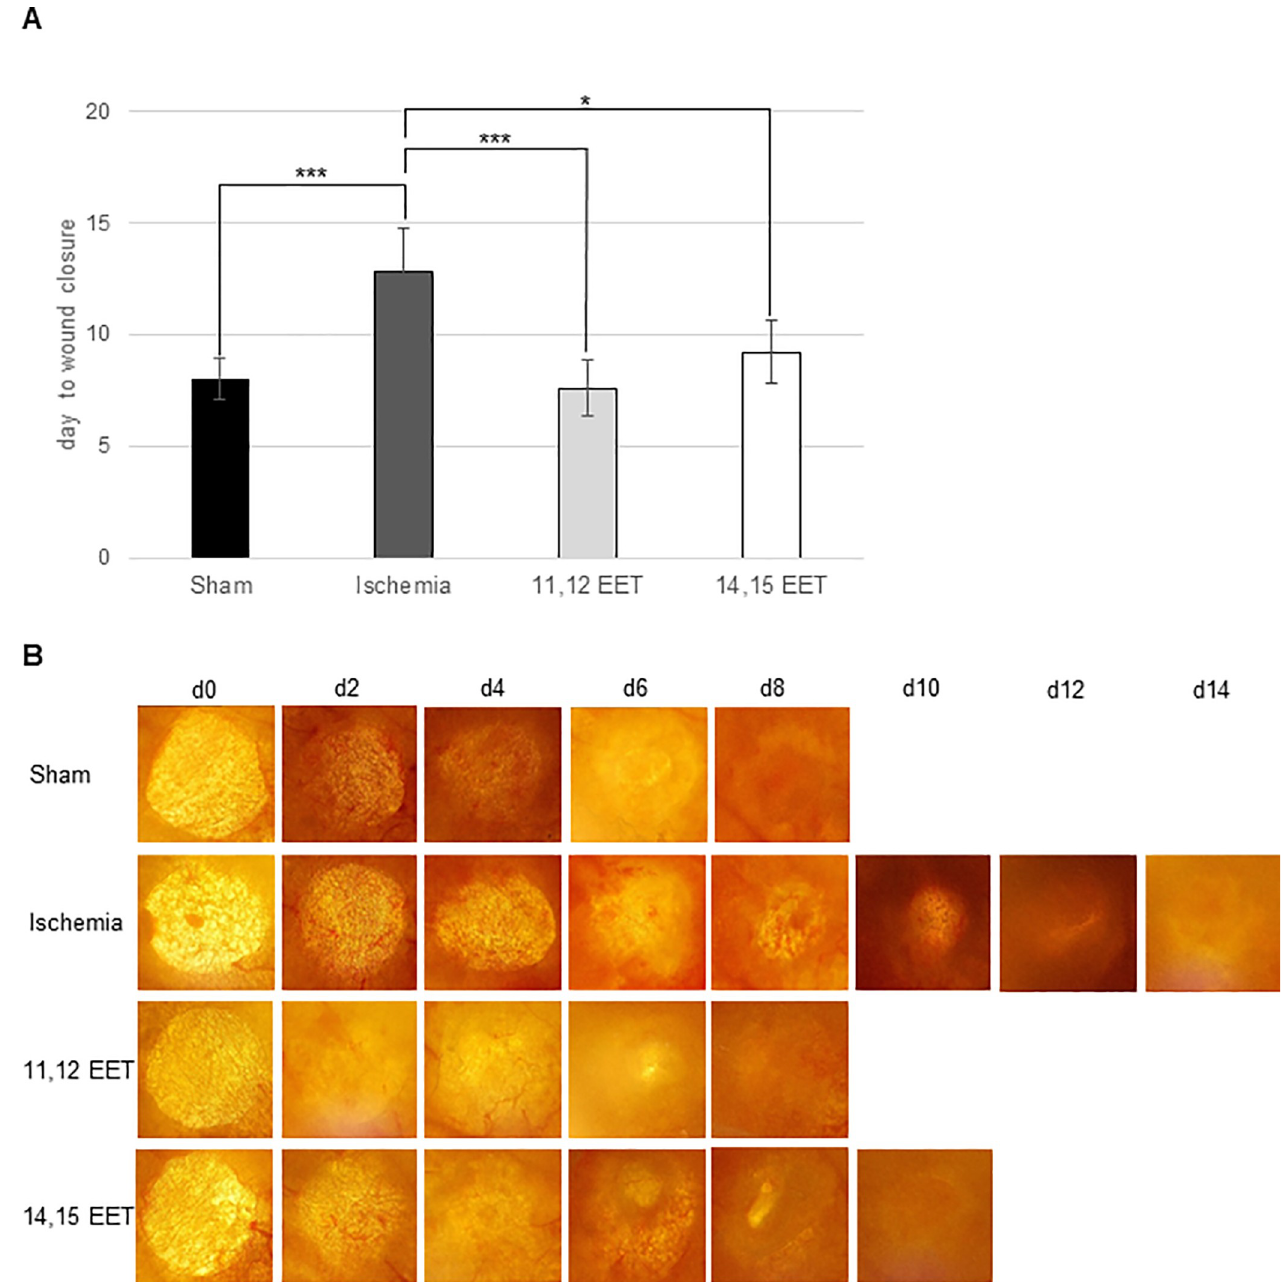
Fig 1. A Day of wound closure. Depicted is day of wound closure of controlwounds, ischemic wounds and ischemic wounds after treatment with 11,12 and 14,15 EET. B Representative in vivo pictures of wound healing taken every second day (data is shown as mean ± SD; n = 10 ). � p < 0.05, �� p < 0.01, ��� p < 0.001.